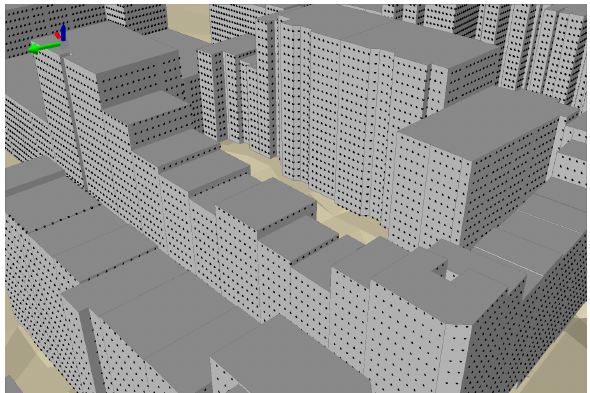
Figure 4. Hyper-Points, 1 meter spacing (1.5x exaggeration, green arrow =